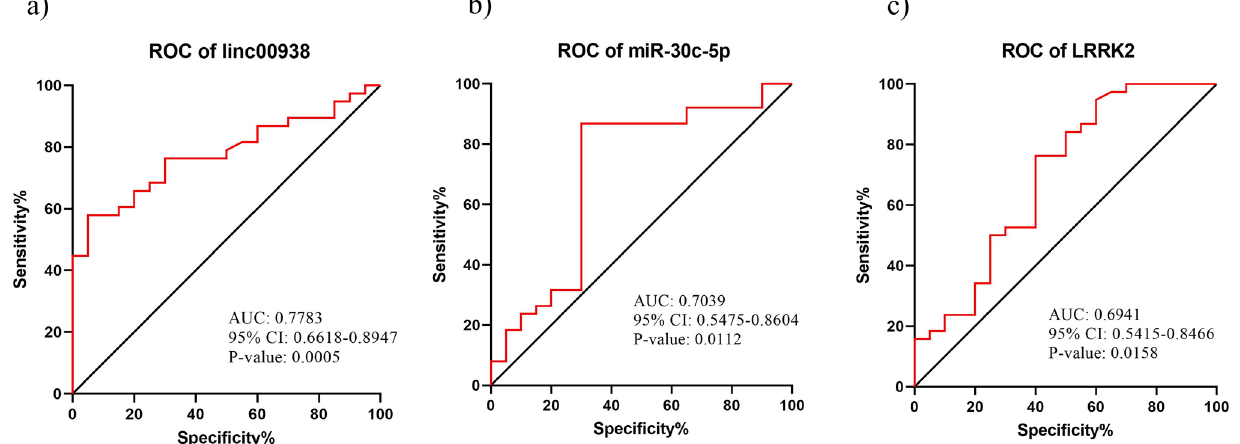
Figure 4. Analysis of the ROC curve for: ( a – c ) linc00938, miR-30c-5p and LRRK2 in the PD patients, as compared to the healthy